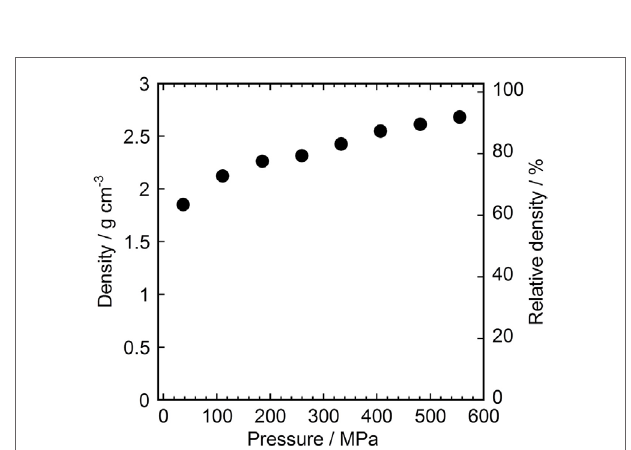
FigUre 4 | Molding pressure dependence of the relative density of li 3 nbs 4 .